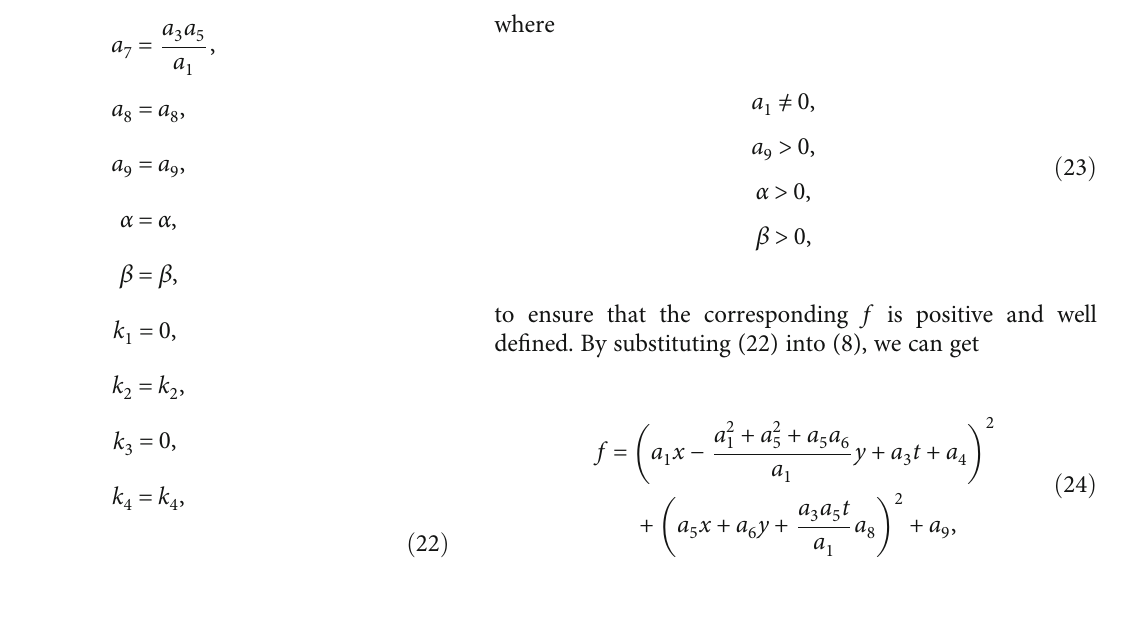
Figure 2: Pro fi les of the solution u via (25a) with a dimensional plot; (b – d) the corresponding density plots with di ff erent